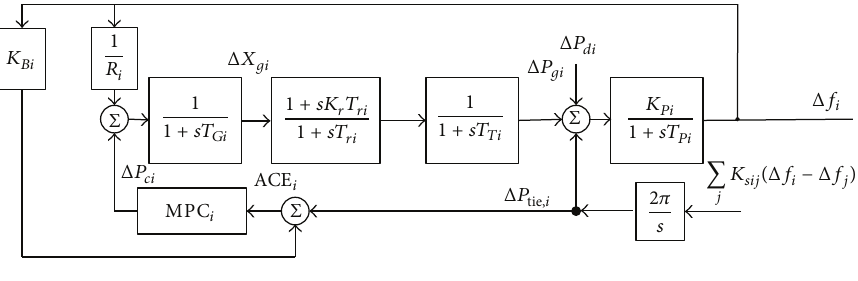
Figure 4: Block diagram of a thermal power plant ( 𝑖 = 4 ).